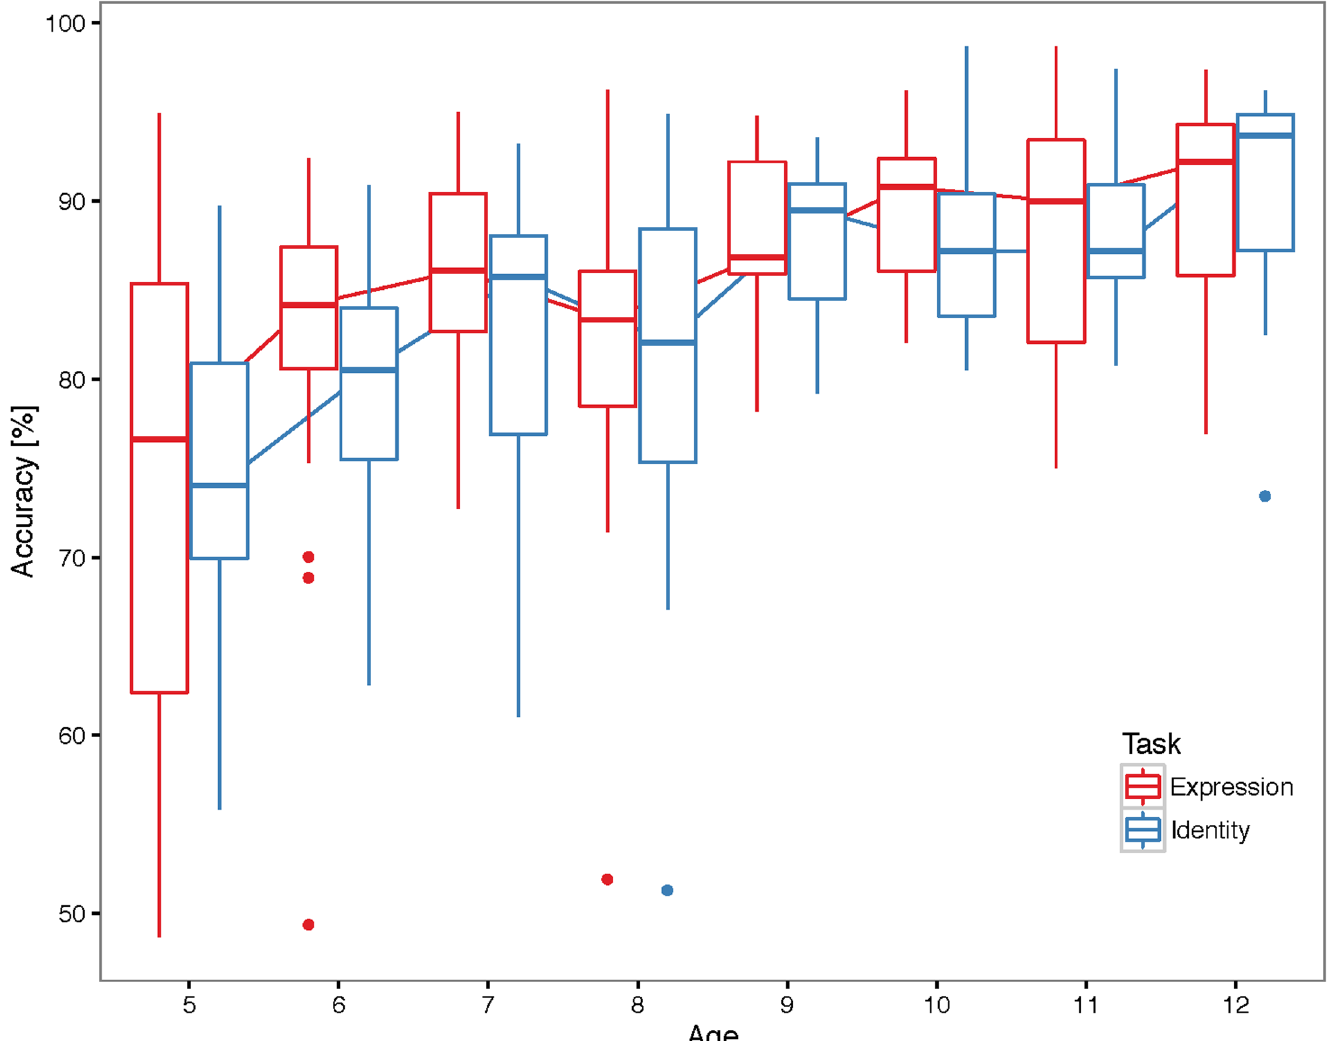
Fig 2. Participant accuracy. Boxplots showingaverageaccuracy for subjectsin each age group and task. Individual points represent outlier subjects (definedas those points exceeding1.5 times the inter-quartile range). Accuracies increasedwith age, and were similar for both tasks.